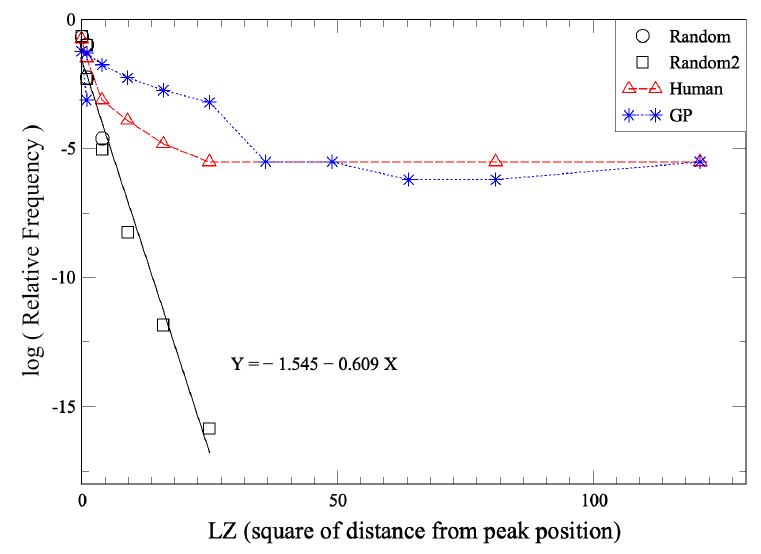
Figure 8. Relative frequency distribution of Lempel–Ziv complexity obtained from the set of RPS time series. The data are the same as those in Figure 6.